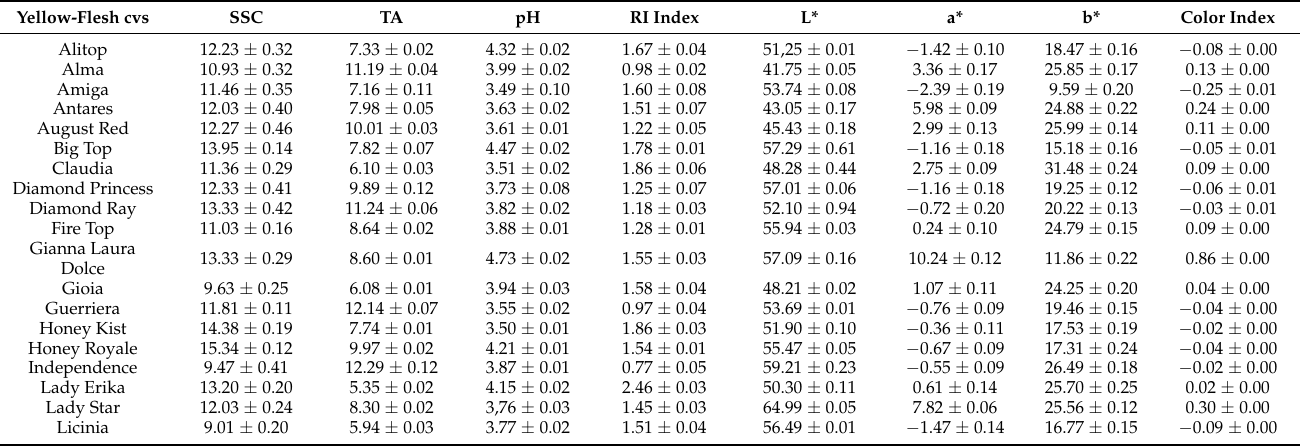
Table 2. Values of Quality Indices SSC ( ◦ Brix, total soluble solids content), TA (g malic acid L − 1 , titratable acidity), pH, RI (ripening index), and flesh color (L, a*, b*) of yellow and white